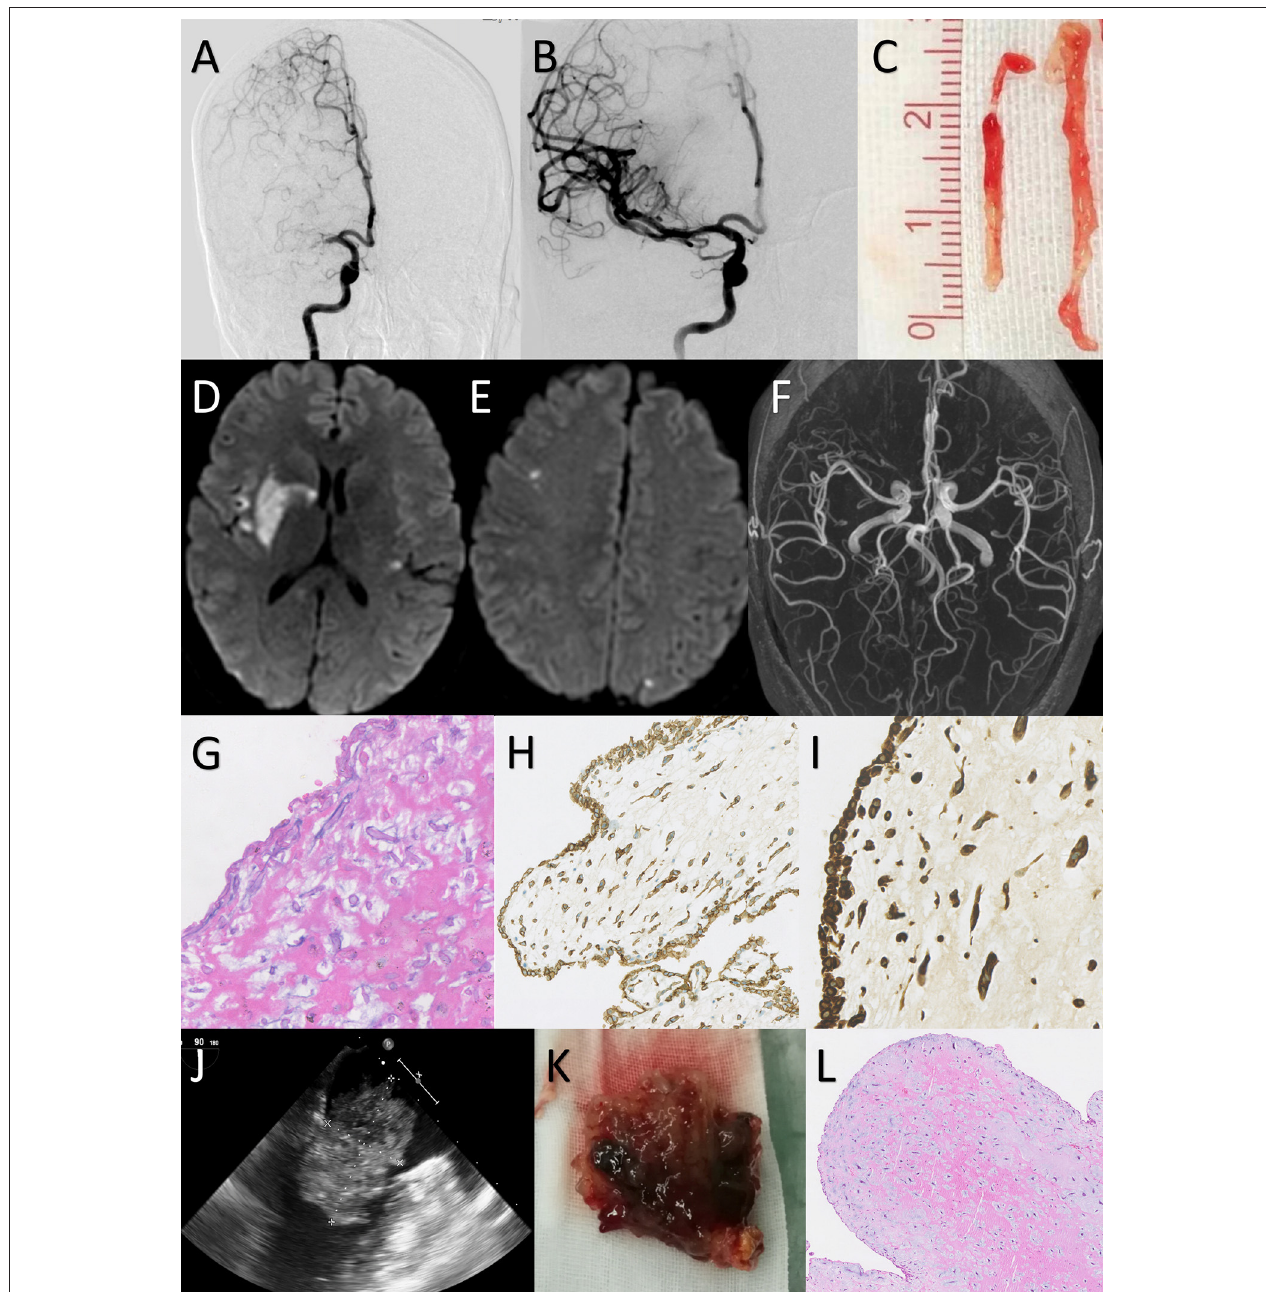
FIGURE 2 | Case 1: a 38-year-old female presented with an NIHSS score of 11 points. Mechanical thrombectomy was performed due to the absence of early neurological improvement with intravenous thrombolysis. (A) Digital subtraction angiography confirmed that the right M1 segment of the middle cerebral artery (MCA) was occluded. (B) After the first attempt with Trevor 4 × 20mm stent retriever, angiography showed complete recanalization of the MCA with a TICI score of 3. (C) The gross appearance of retrieved embolus: long yellowish and gelatinous tissue. (D,E) The diffusion-weighted magnetic resonance imaging on Day 3 showed acute infarction in the right basal ganglia and bilateral cerebral cortex. (F) Magnetic resonance angiography on Day 3 showed no vascular abnormalities. (G–I) Hematoxylin and eosin (H&E) staining of the retrieved embolus demonstrates round and spindle cells with a myxoid matrix. Staining for CD34 and vimentin were strongly positive. This histopathological view indicated the embolus was originated from cardiac myxoma. [ G : H&E staining 200 × ; H : CD34 staining 100 × ; I : vimentin staining 200 × ] (J) Transesophageal echocardiogram showed a 53 × 56mm myxoma in the left atrium. (K) Gross examination revealed a 55 × 58 × 40-mm-sized reddish-brown myxoid mass with an irregular surface. (L) Histological examination of the removed cardiac mass showed myxoma cells singly within the myxoid matrix, confirming the diagnosis of a cardiac myxoma.